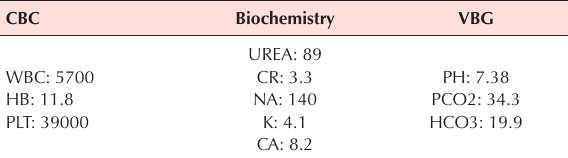
Table 2 . Patient blood tests after surgery CBC Biochemistry